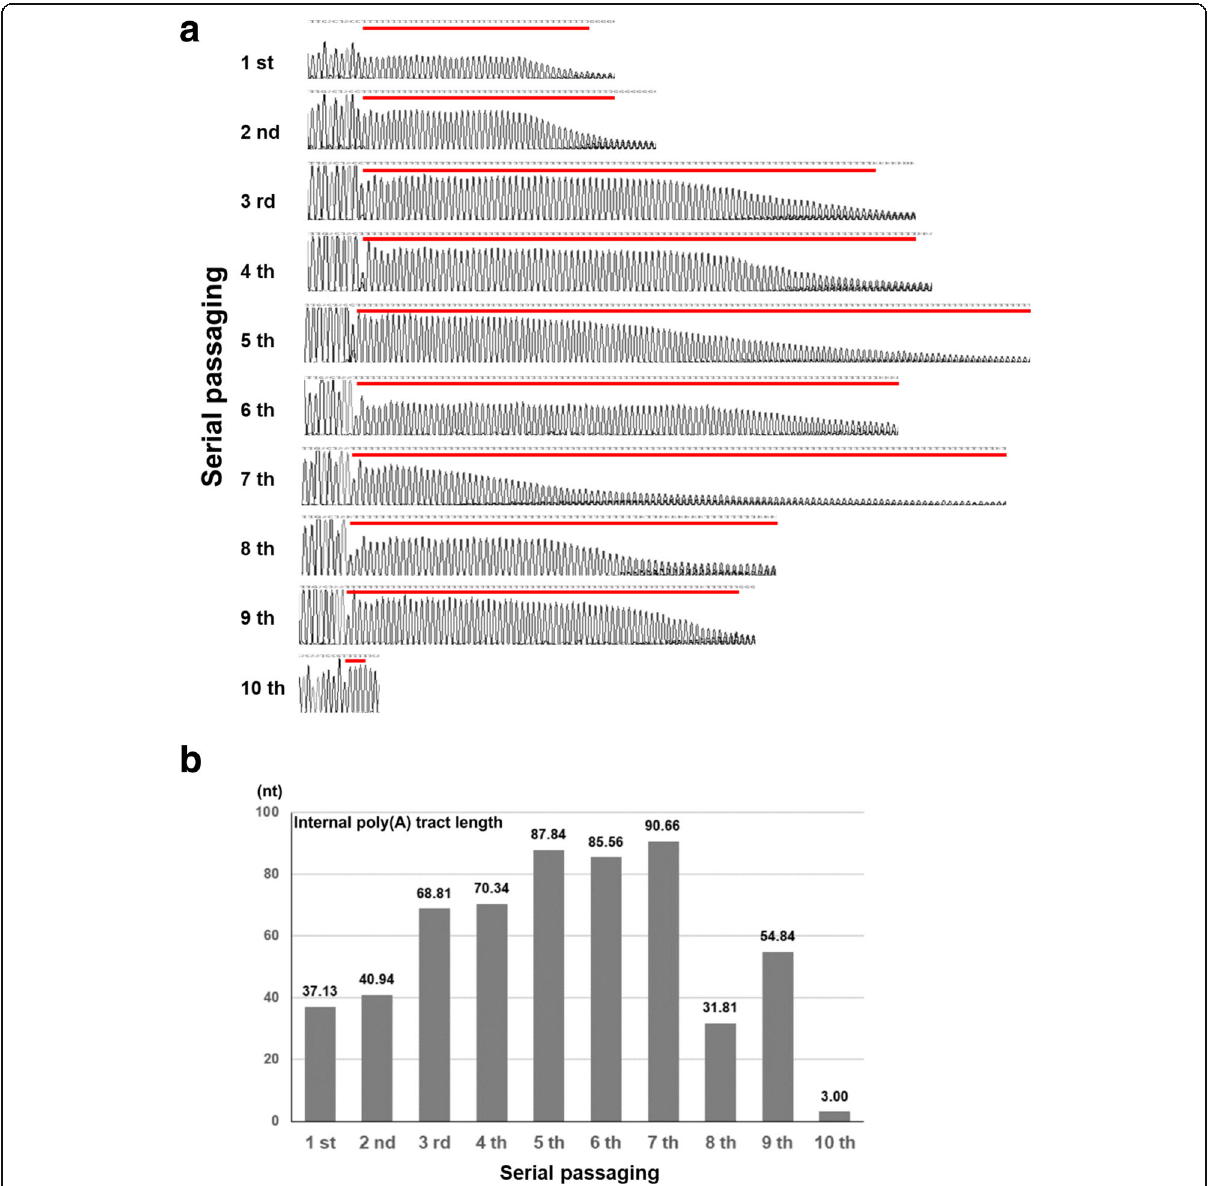
Fig. 4 a DNA sequencing results of 10 rounds of serial passaging of TMV (24A + UPD) in N. benthamiana plants, showing variations of internal poly(A) tract length (red line) in viral genome. b Average length of internal poly(A) tract in 10 rounds of serial passaging of TMV (24A +